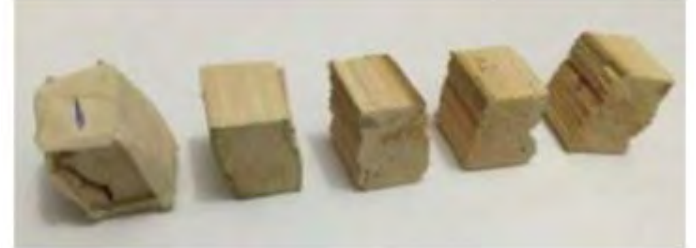
Figure 29. The failure patterns of the compression specimens (Author’s own, n.d.)